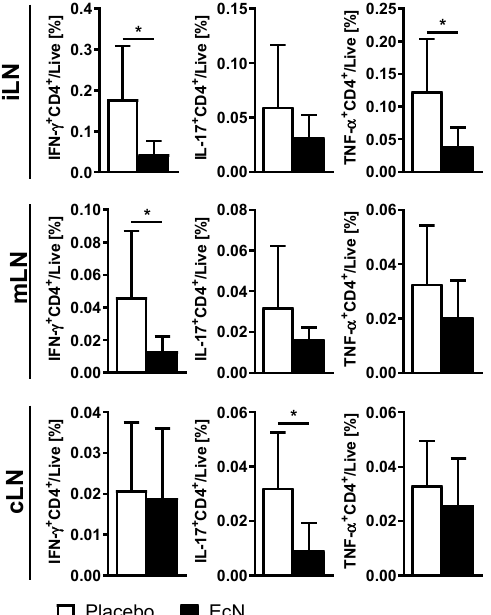
Figure 5. Oral live EcN suppresses the response of helper T cells to IRBP in the inguinal, mesenteric and cervical lymph nodes at day 28 post-induction, as measured by FACS. Differences were quantified by unpaired Mann Whitney test; * p < 0.05 ( n = 5–8 per group).